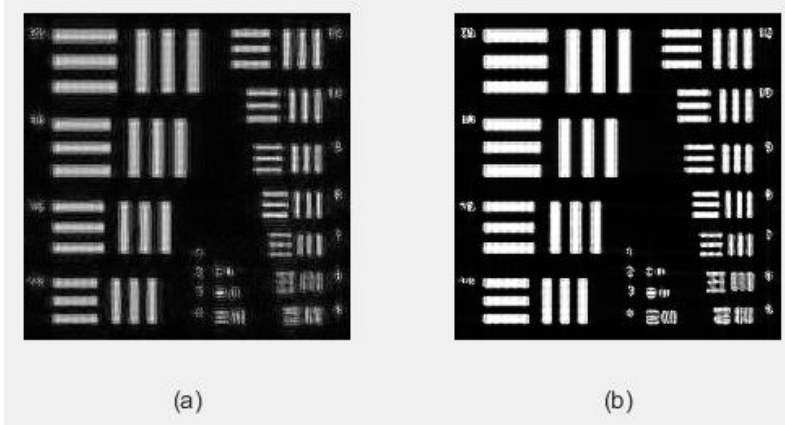
Figure 13. The overlap rate was reduced from 0.7 to 0.2. ( a ) The effect of reconstruction using the AMPR algorithm ， SSIM = 0.2143; ( b ) The effect of reconstruction using Algorithm 1 ， SSIM = 0.5941.